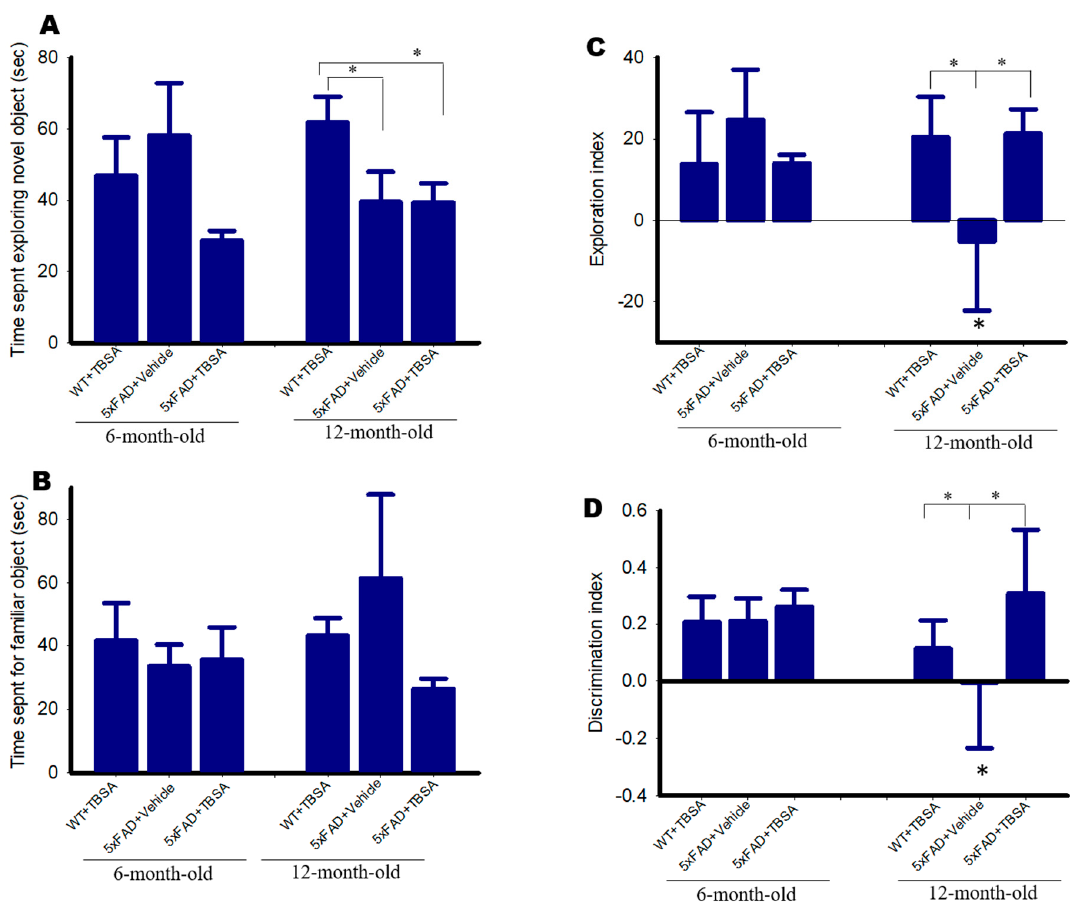
Figure 8. Treatments of trans-beta-styryl-boronic acid (TBSA) compound improved recognition memory in 5xFAD mice. Six- and twelve-month-old 5xFAD and age-matched control mice were tested on the novel object recognition (NOR) task after treatment with TBSA (0.5 mg / kg) for 2 months. ( A ): The 12-month-old 5xFAD mice, but not 6-month-old mice spent less time exploring the novel object than WT mice, but this recognition deficit was unaltered in 5xFAD mice treated with TBSA. ( B ): The 12-month-old 5xFAD mice showed a trend toward spending more time in exploring familiar objects than WT mice and 5xFAD + TBSA mice. The exploration index ( C ) and the discrimination index ( D ) revealed that 12-month-old 5xFAD, but not in 6-month old 5xFAD mice, that were treated with TBSA showed preservation of their recognition memory. Values are expressed as means ± SEM. * p < 0.05 in comparison to WT + Vehicle and 5xFAD + TBSA